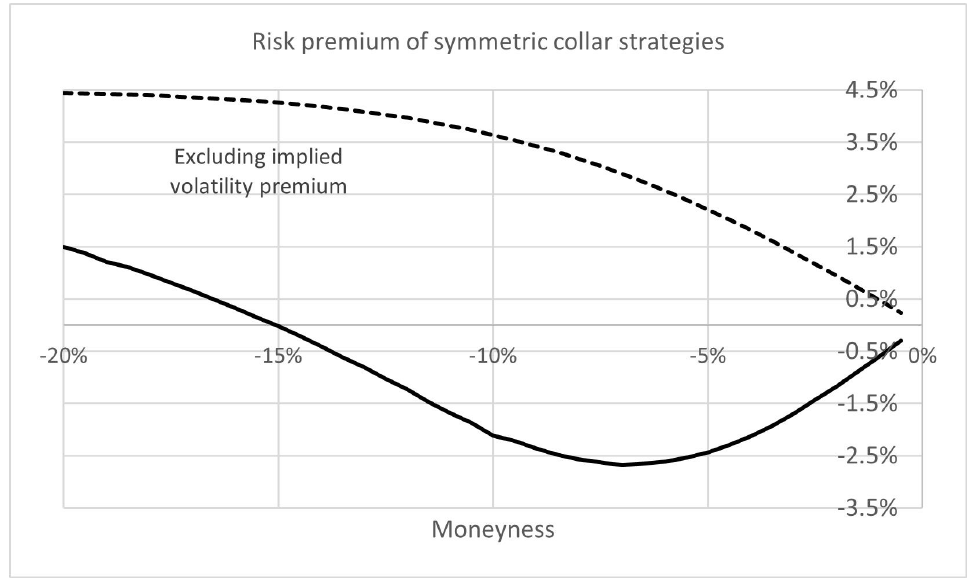
Figure 15. The risk premium for an underlying asset with an overlaid symmetric collar strategy for a range of strike prices. The dotted line assumes the implied volatility is equal to the underlying asset volatility. The solid line includes the implied volatility premium in the price of the